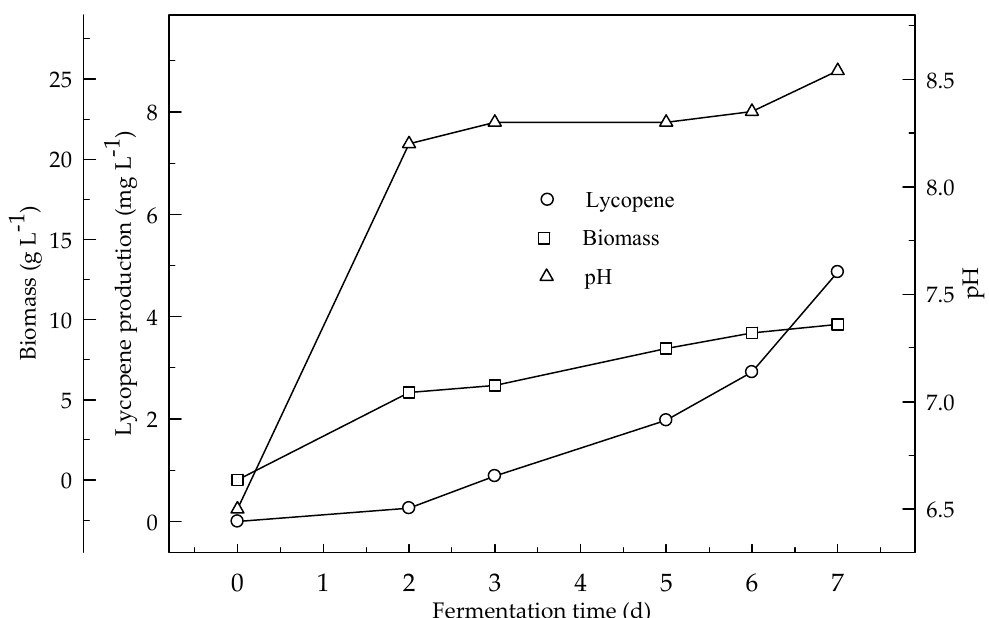
Figure 9. Changes in lycopene production, biomass formation and pH in a fermentor with an initial pH 6.5 from a 1% orange powder in a fermentor with aeration 3 L min − 1 at agitation 500 rpm.